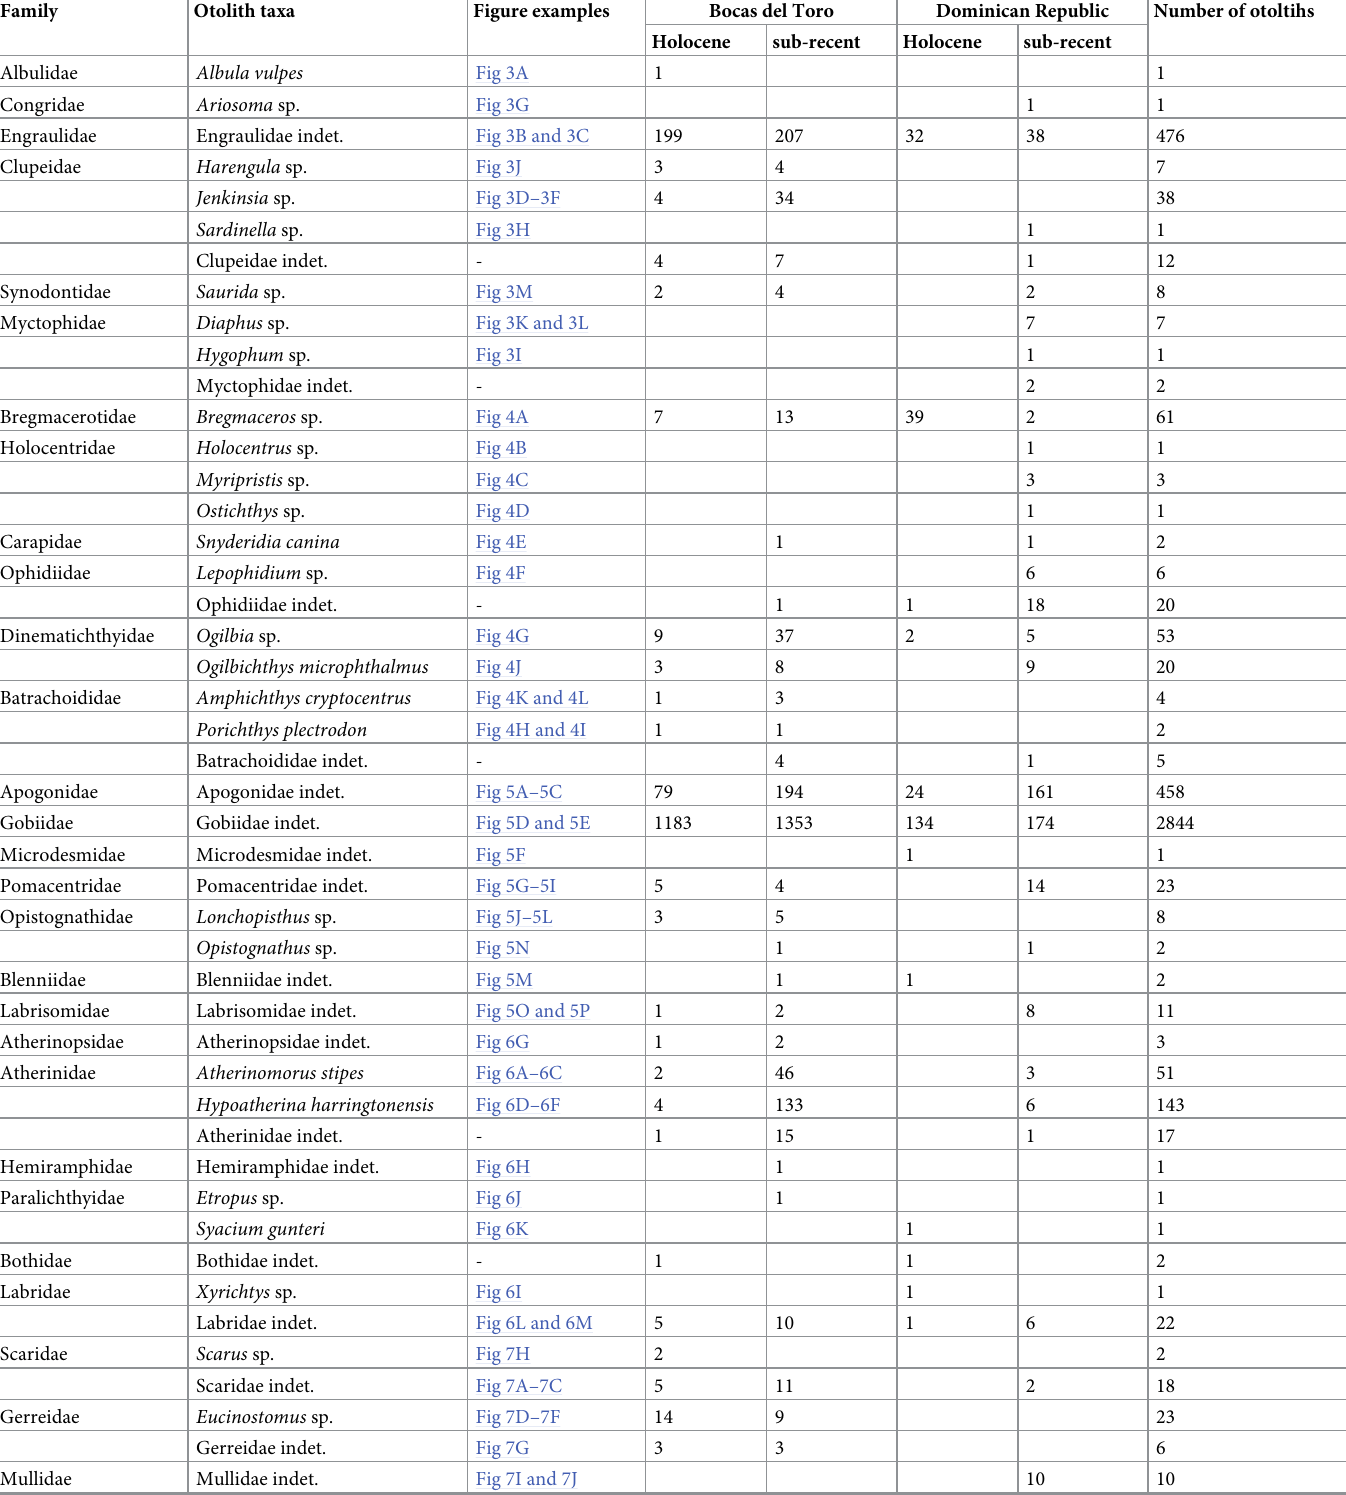
Table 3. Otolith-based fish taxa identified in this study, with number of identified